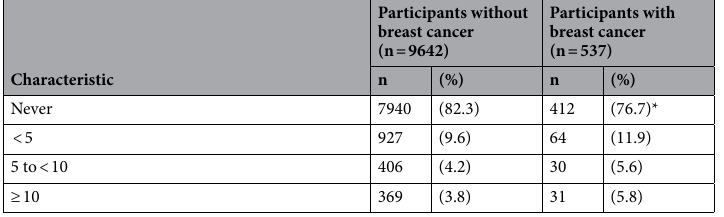
Table 1. Characteristics of participants, stratified by breast cancer. BMI, body mass index; E, estrogen; E + P, estrogen + progestin; SFA, saturated fatty acids; MET, metabolic equivalent; MFA, monounsaturated fatty acids; PFA, polyunsaturated fatty acids; RSF, random survival forest. * p < 0.05, chi-squared or Wilcoxon’s rank-sum test. a Depression scales were estimated using a short form of the Center for Epidemiologic Studies Depression Scale. b Dietary alcohol per day was stratified at 18 g/day, where the cutoff level or higher fall within the high-risk group in the RSF model. c Physical activity was estimated via recreational physical activity combining walking and mild, moderate, and strenuous physical activity. Each activity was assigned a MET value corresponding to intensity; the total MET hours week −1 was calculated by multiplying the MET level for the activity by the hours exercised per week and summing the values for all activities. The total MET was stratified into 2 groups, with 10 METs as the cutoff according to current American College of Sports Medicine and American Heart Association recommendations 102 . d BMI, waist circumference, and waist-to-hip ratio were categorized at 30 kg/m 2 , 88 cm, and 0.85, respectively, where those cutoff levels or higher fall within the overall or visceral obese range (https ://www.cdc.gov/obesi ty/adult /defin ing.html) 103